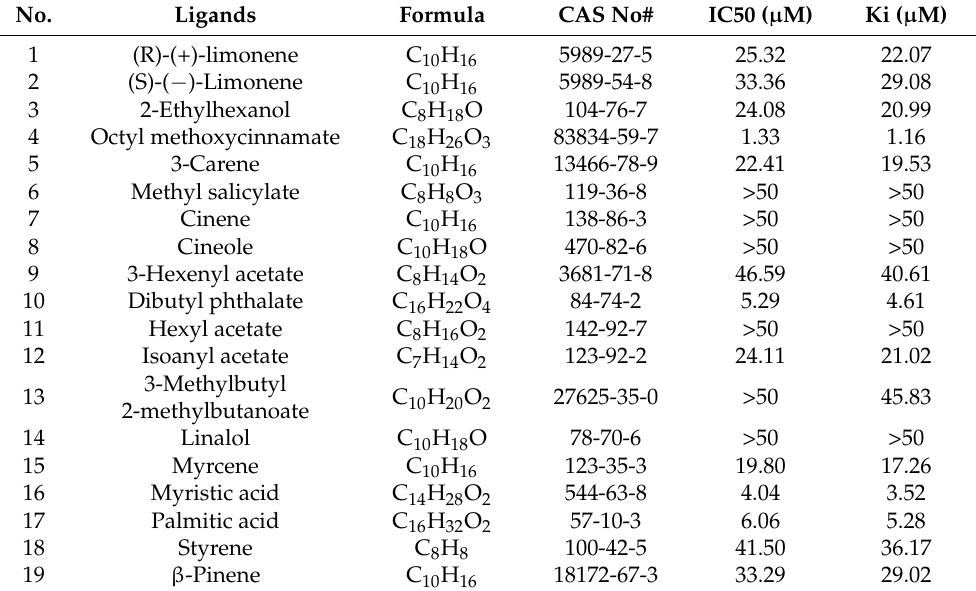
Figure 6. Competitive fluorescence ligand-binding assay of TrufOBP4 to volatiles. ( A ) Binding curve and relative Scatchard plot of TrufOBP4 and 1-NPN. ( B ) Competitive binding curves of TrufOBP4 with alkene, esters, fatty acids and alcohols. Table 1. Binding affinities of different ligands to TrufOBP4.